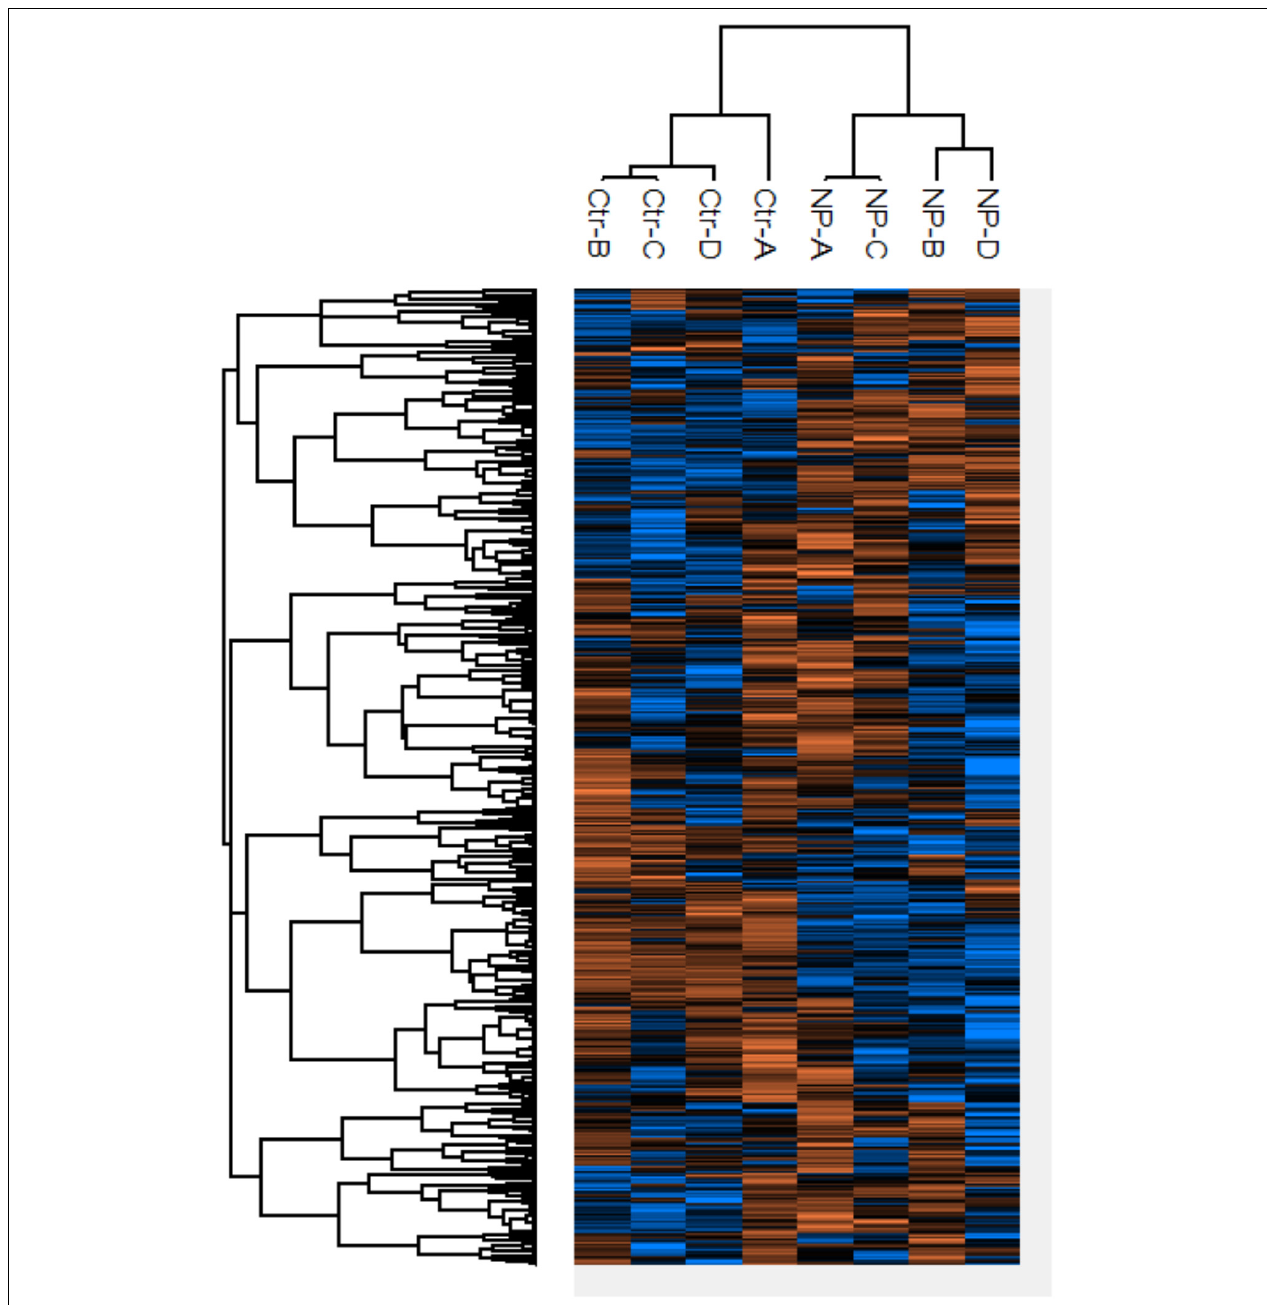
FIGURE 5 | Heat map of D. vulgaris proteins of which the expression changed significantly between SNP treated (NP) and non-treated control (Ctr) incubations. The values were from log 2 transformed and range from low (blue) to high (orange)